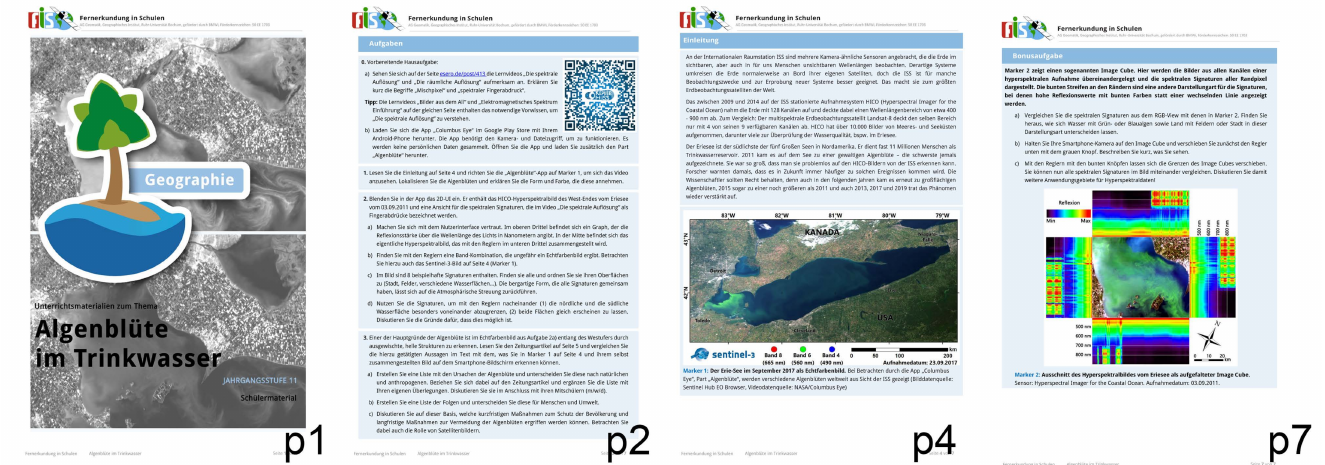
Figure 13. Worksheet “Algal bloom in the water supply”. ( P1 ): cover sheet, doubles as marker image for maps in Figure 14. ( P2 ): Tasks 0 (preparatory) to 3. ( P4 ): Introduction text to be read in task 1 and respective marker for the HDEV video ( P7 ): Optional task 5 using the image stack from Figure 12. (Source: authors).